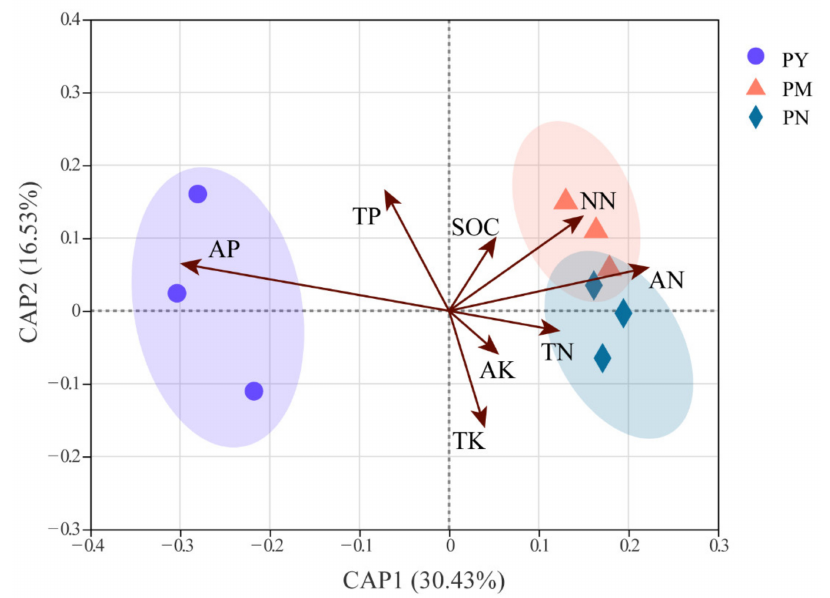
Figure 8. Distance-based redundancy analysis of the composition of rhizosphere soil fungal commu- nity of P. tabuliformis at different stand ages. TN: total nitrogen, NN: nitrate nitrogen, AN: ammonium nitrogen, TP: total phosphorus, AP: available phosphorus, TK: total potassium, AK: available potas- sium, SOC: soil organic carbon, PY: young forest (10a), PM: middle-aged forest (20a), and PN: near-mature forest (30a).